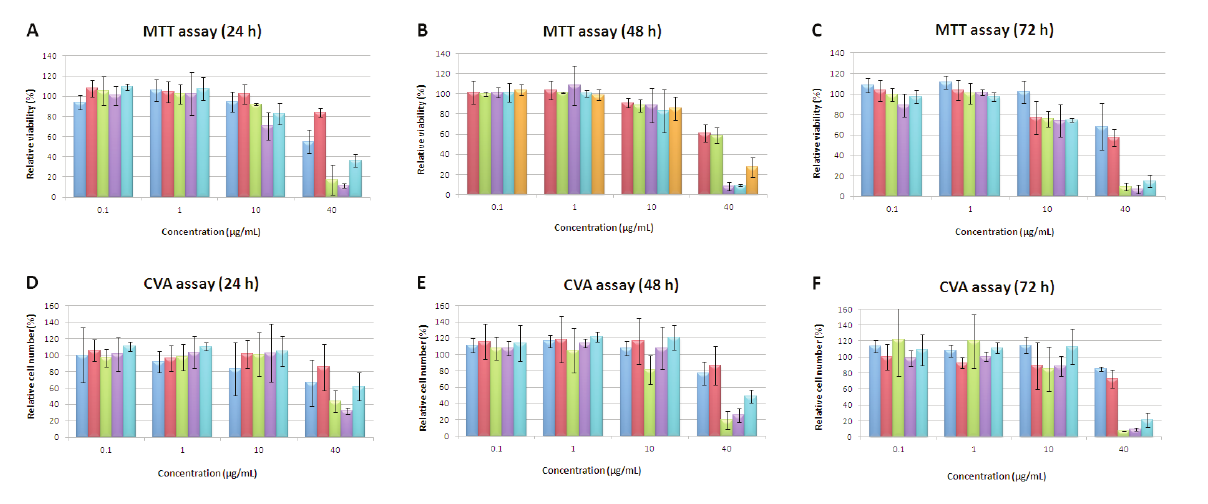
Figure 1. Cell viability percentage of A549 cells was estimated by MTT and cell number by crystal violet assay in 96-well plates following 24-, 48- or 72-hour exposure to H. magnifica , H. crispa , H. malu , C. adhaesivum and E. quadricolor (each represented individually as bars from left to right respectively). Data is shown as mean ± SEM of three separate experiments. Treatments significantly different from the untreated control at p < 0.05 are presented as *.